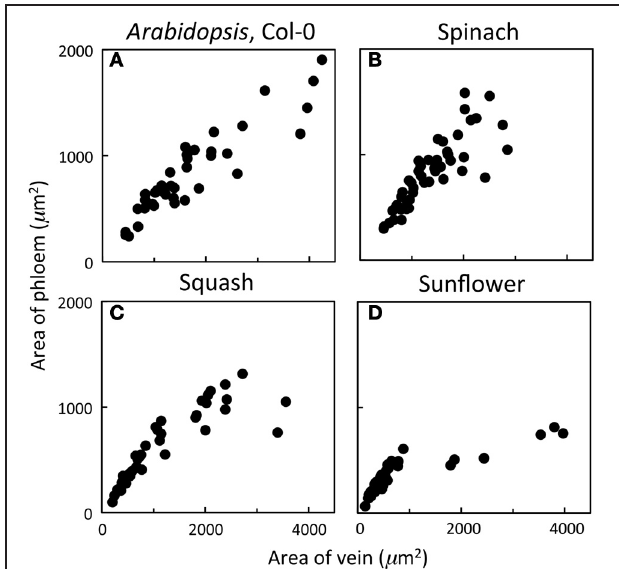
FIGURE 1 | Relationship between the cross-sectional area of phloem (all phloem cells combined) and the cross-sectional area of the entire vein for individual veins of (A) A. thaliana Col-0 ( n = 44), (B) spinach ( n = 45), (C) squash ( n = 48), and (D) sunflower ( n = 65) grown at 25 ◦ C under 400 µ mol photons m − 2 s − 1 .